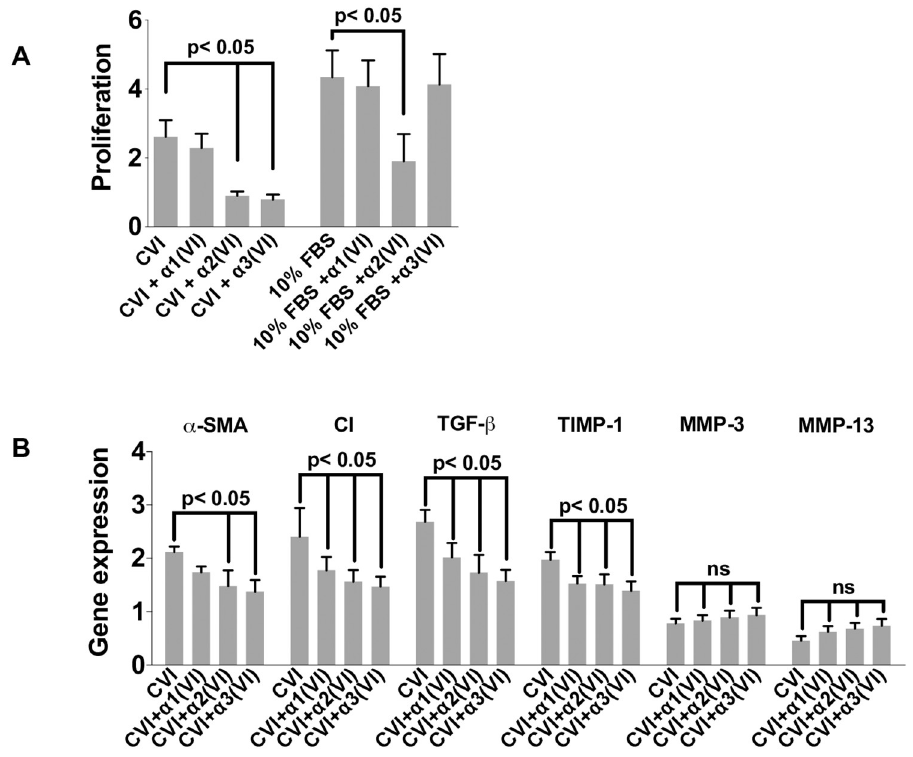
Fig 4. Effects of alpha single chains of CVI on 10% FBS- and CVI-induced proliferation and CVI-induced expression of fibrosis-associated genes in HSC. ( A ) Serum-starved CFSC were treated as indicated for 24 h. Proliferation was determined by [ 3 H]-thymidine incorporation. Shown are Mean ± SD (n = 4). ( B ) Serum-starved CFSC were treated as indicated for 24 h. Gene expressions were determined by quantitative PCR and normalized to GAPDH. Shown are mean values ± SD (n = 4). Fig 4 Statistics were calculated by one-way ANOVA analysis and Tukey’s multiple comparisons test. Differences p < 0.05 were considered significant.